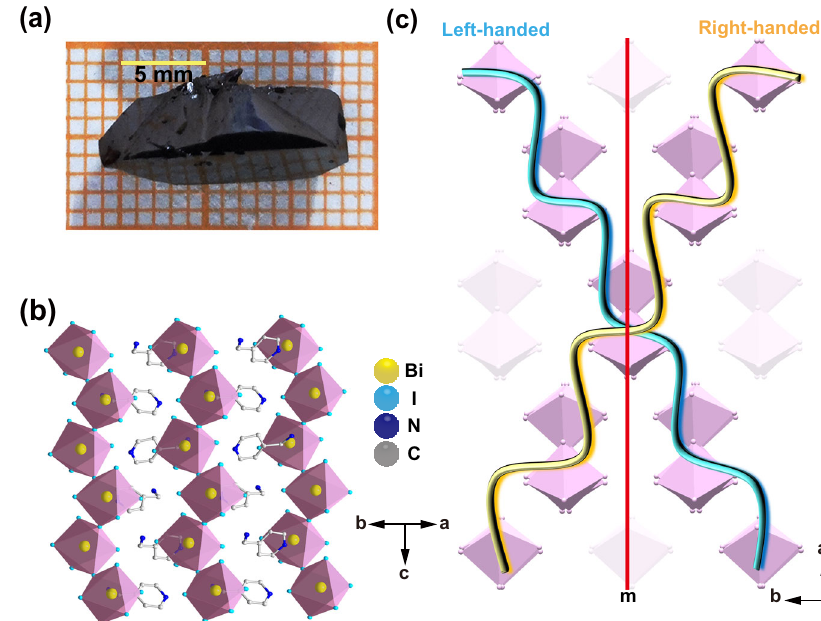
Fig. 2 | Structural characteristics of ABI. a Bulk single crystals of ABI . b The zig-zag chains structureof ABI . c The relationship between the left-handed helix and right- handed helix relative to the m symmetry plane in ABI crystals.